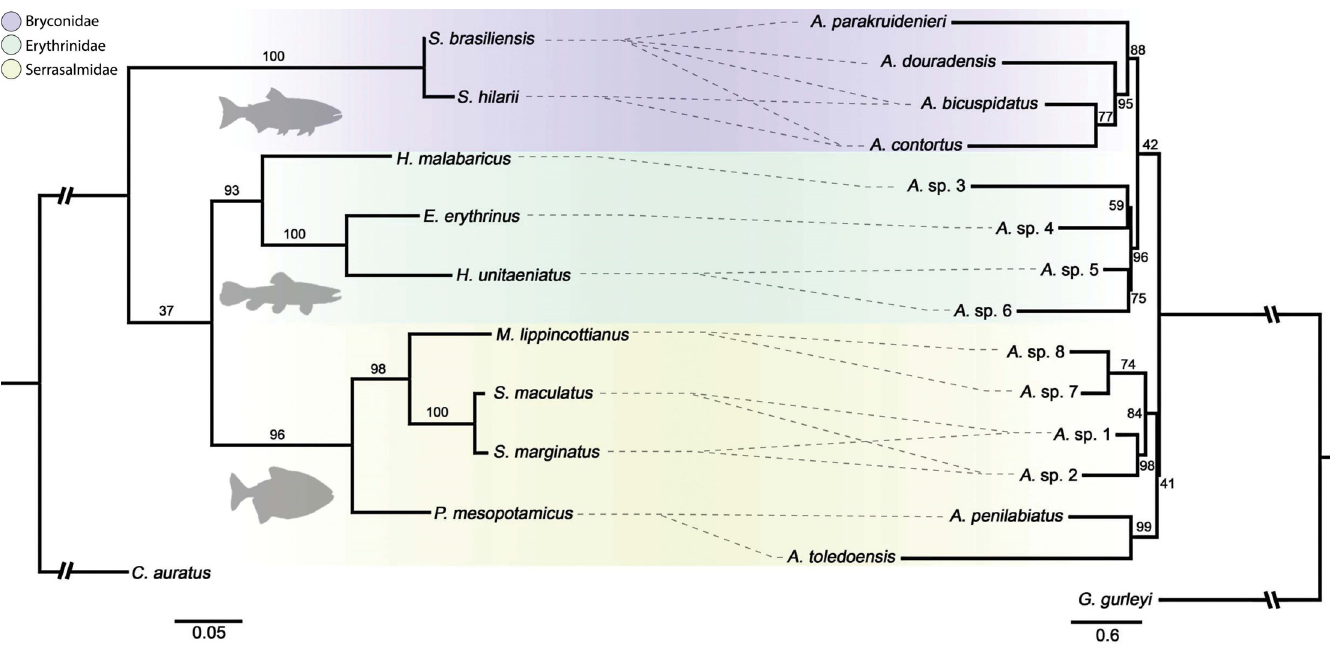
Fig 2. Tanglegram depicting the relationship between nine species of Characiformes (left) and 14 species of Anacanthorus (right) . Background colours correspond to the three families of hosts represented and their respective parasite species. Dotted lines indicate the host-parasite associations. Abbreviations of Anacanthorus spp.: A.sp. 1 = Anacanthorus sp. 1; A.sp. 2 = Anacanthorus sp. 2; A.sp. 3 = Anacanthorus sp. 3; A.sp. 4 = Anacanthorus sp. 4; A.sp. 5 = Anacanthorus sp. 5; A.sp. 6 = Anacanthorus sp. 6; A.sp. 7 = Anacanthorus sp. 7; A.sp. 8 = Anacanthorus sp. 8.